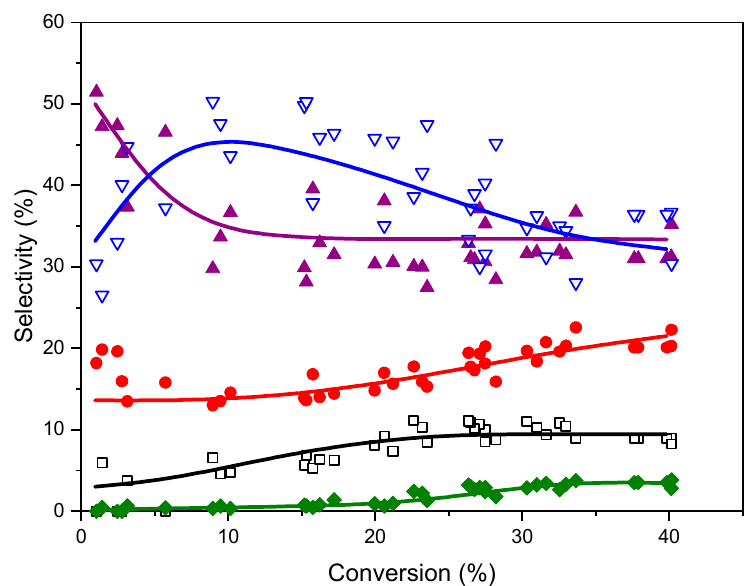
Figure 9. Selectivity to hydroperoxide (down triangles), cyclohexenol (circles), cyclohexenone (up triangles), epoxide (squares) and cyclohexanediol (diamonds). Data collected for the five Au catalysts of Figure 7. Lines are drawn for visual guide only and have been computed to provide a 100% value for the total sum of selectivities at any conversion level.